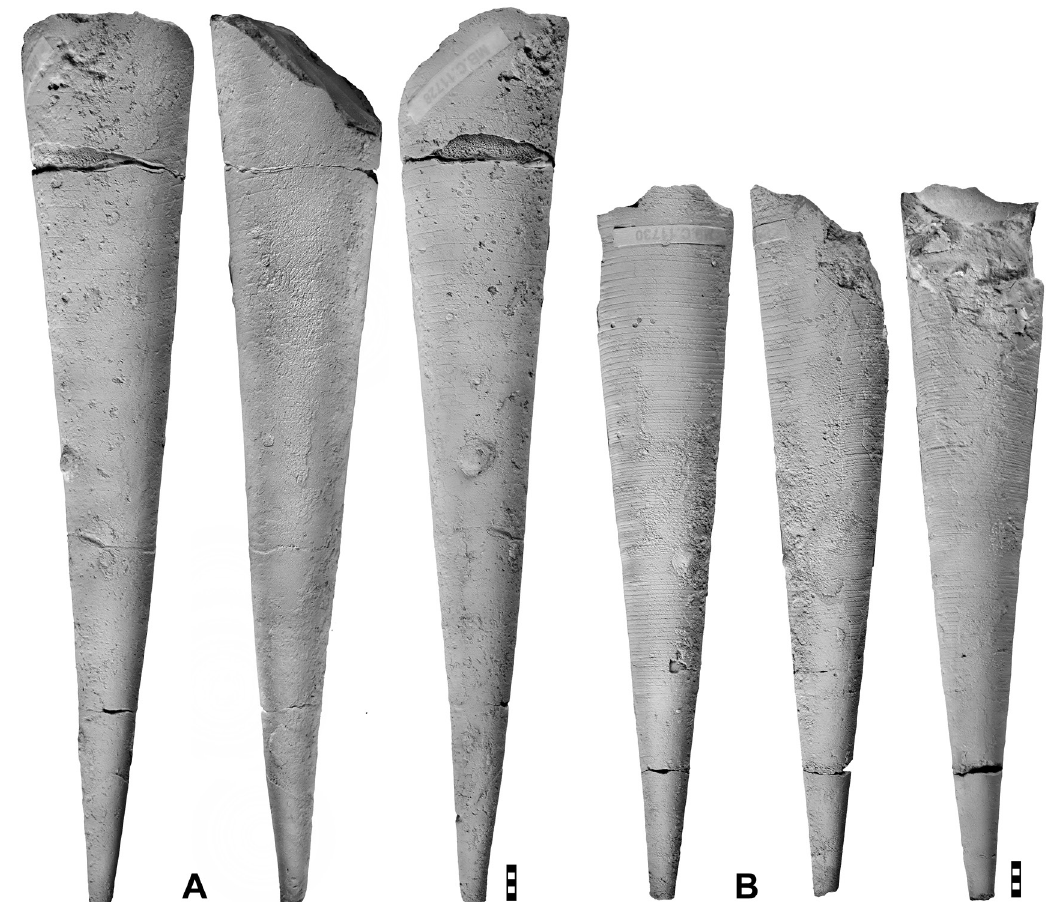
Fig. 15. Species of Rhynchorthoceras from the Upper Red Orthoceratite Limestone. A . Rhynchorthoceras rugium sp. nov., holotype MB.C.11728 (Hoffmann & Gager 1972 Coll.) from Mönchgut (Island of Rügen); lateral, dorsal and ventral views. B . Rhynchorthoceras kranepuhlense sp. nov., holotype MB.C.11730 (Kummerow Coll.) from Kranepuhl (Brandenburg); ventral, lateral and dorsal views. Scale bar units = 1